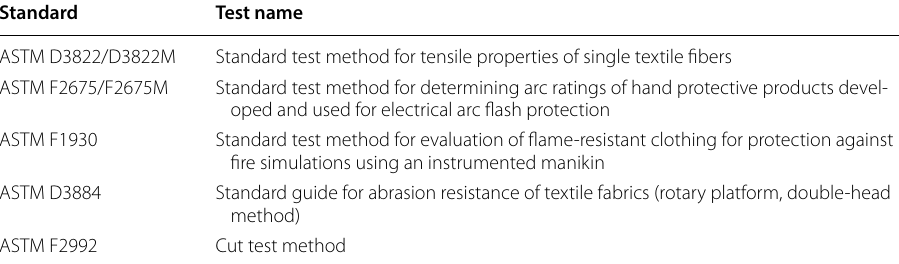
Table 4 Commonly used ASTM standardized tests to evaluate materials, components and whole